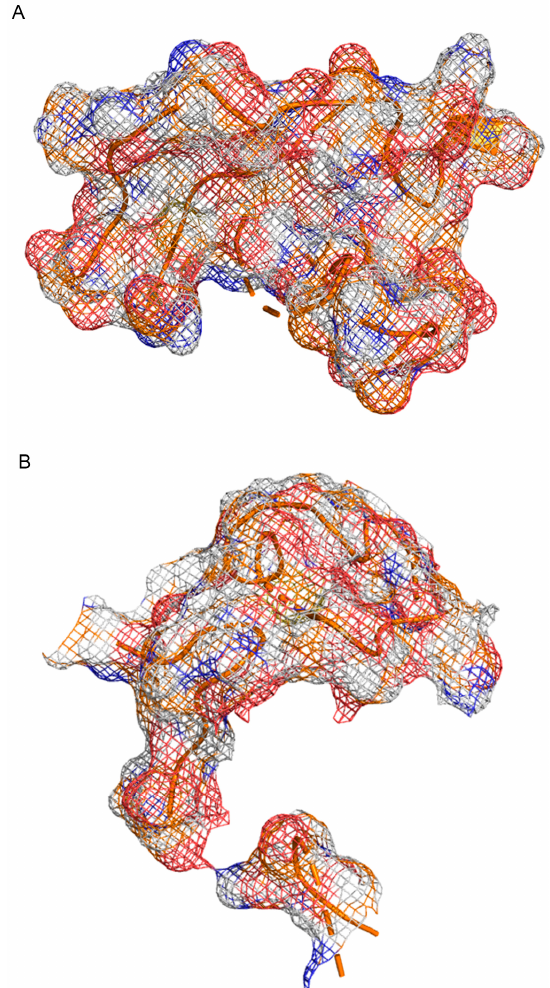
Figure A7. ( A , B ) show the grouping of binding site and highly flexible regions respectively. Figure A7. ( A,B ) show the grouping of binding site and highly fl exible regions respectively.